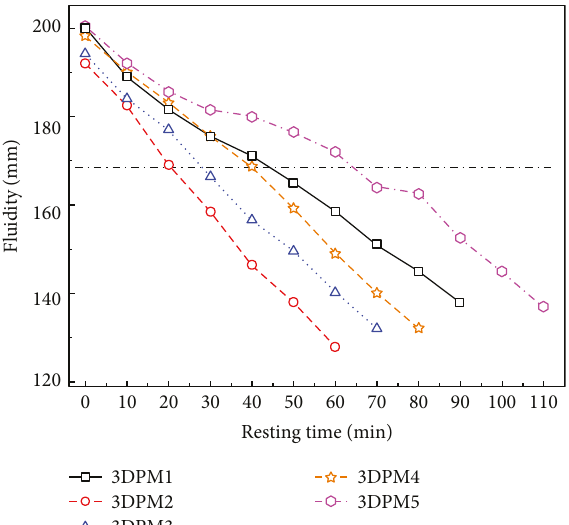
Figure 18: Flowability of ordinary concrete and recycled sand concrete doped with different proportions of sodium gluconate [38].